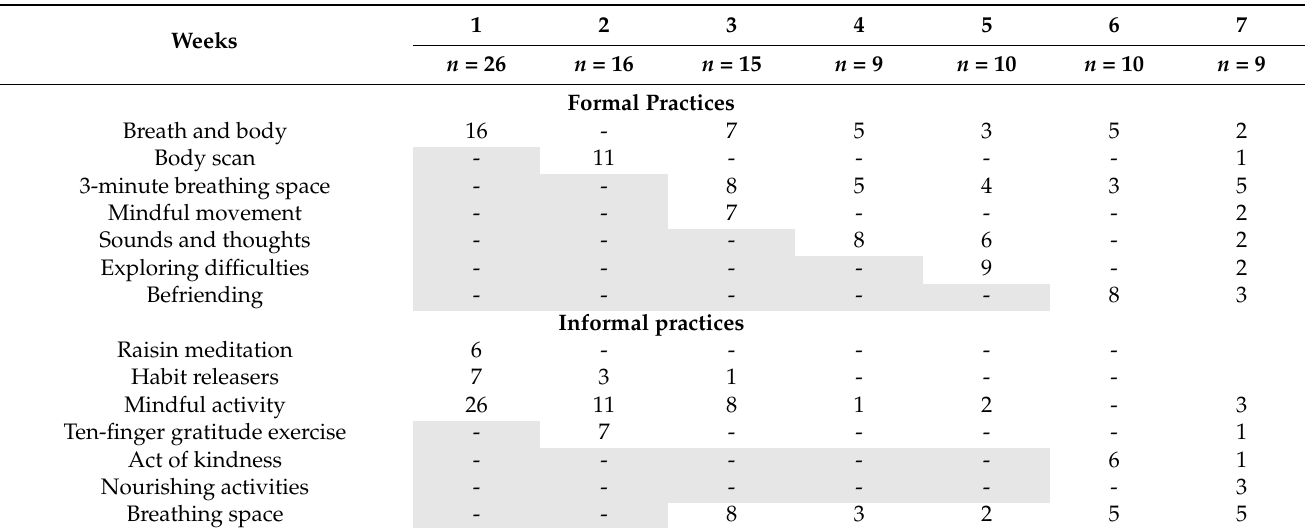
Table 5. Weekly Formal and informal mindfulness practices completed by participants (weekly submitted